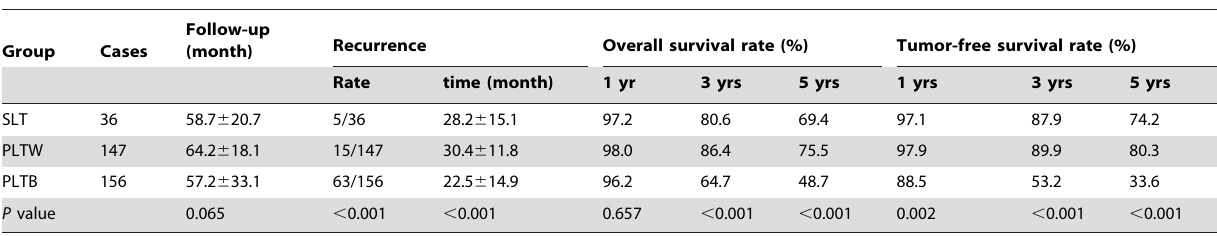
Abbreviation: SLT, salvage liver transplantation; PLTW, primary liver transplantation for HCC within Milan criteria; PLTB, primary liver transplantation for HCC beyond Milan criteria.